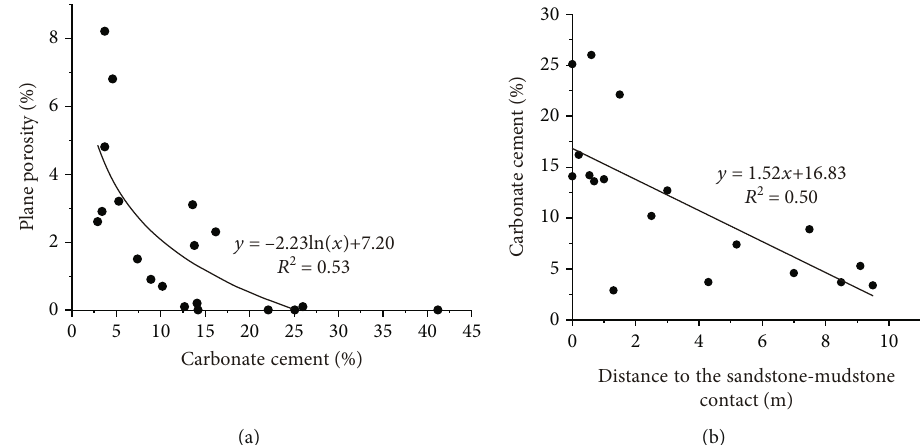
Figure 20: Relationship between the content of carbonate cement, plane porosity of thin section, and the distance from sandstone – mudstone contact.